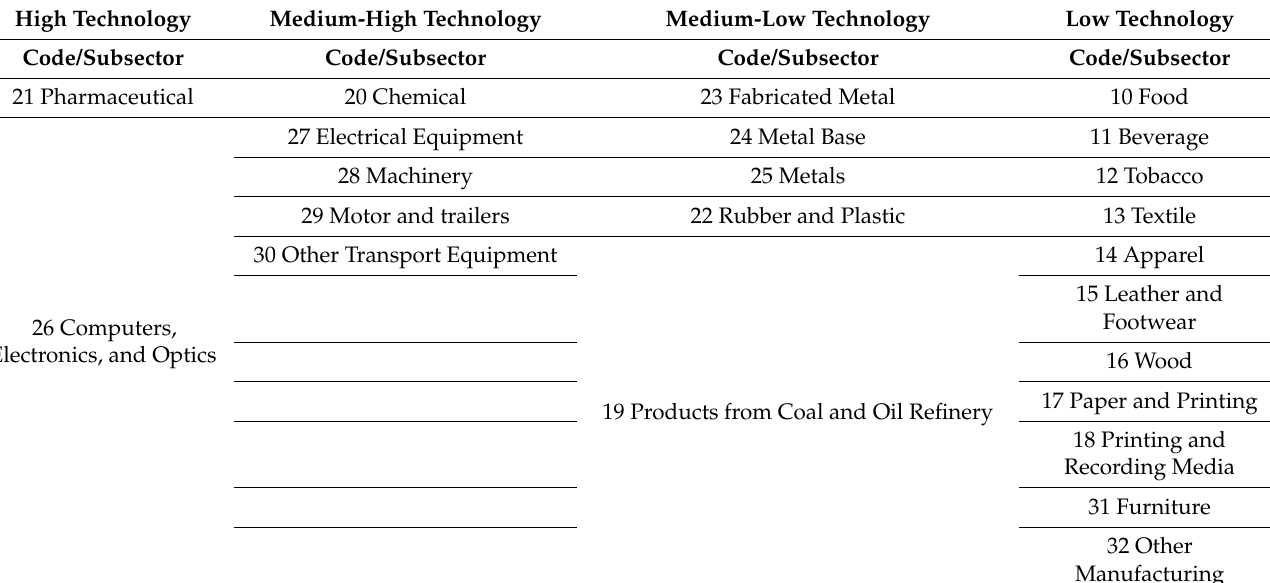
Table 2. Classification of high technology and low